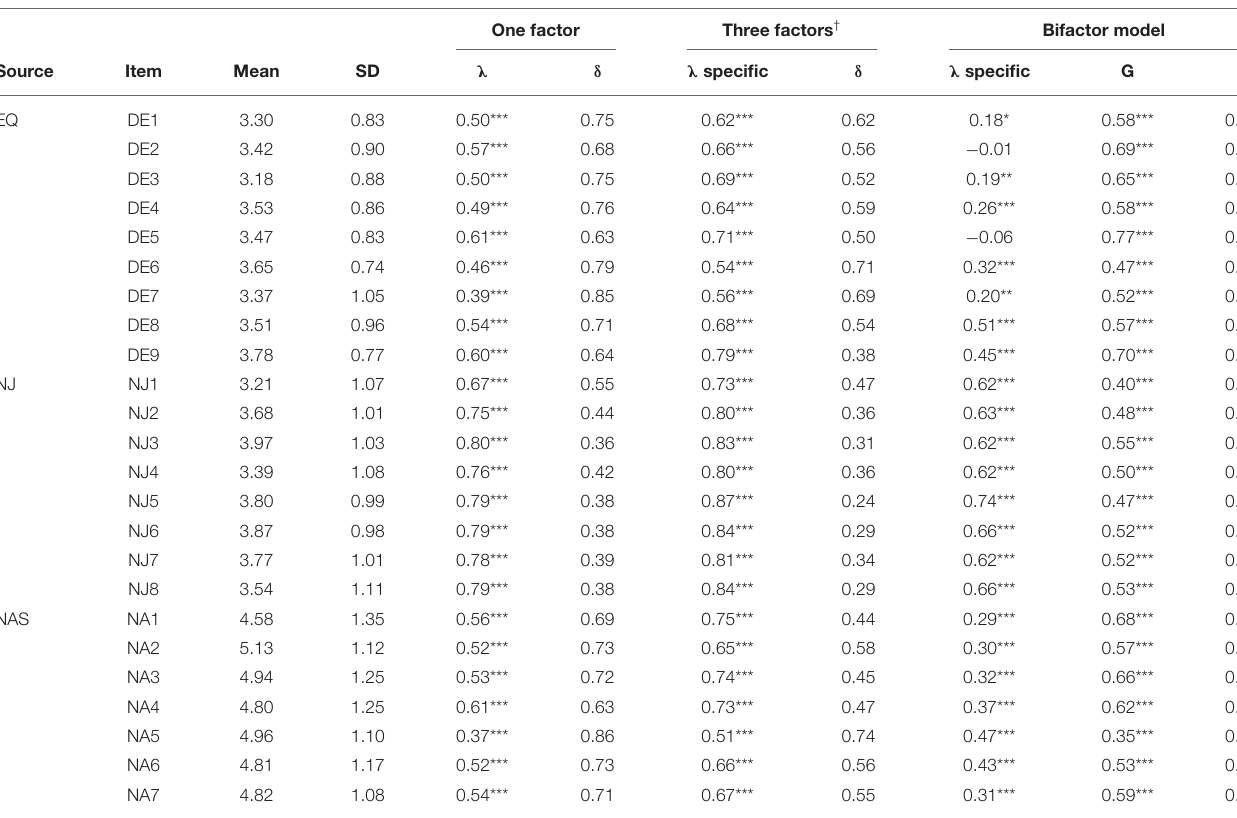
TABLE 5 | Descriptive statistics of the items and confirmatory factor analyses (subsample 2). One factor Three factors † Bifactor